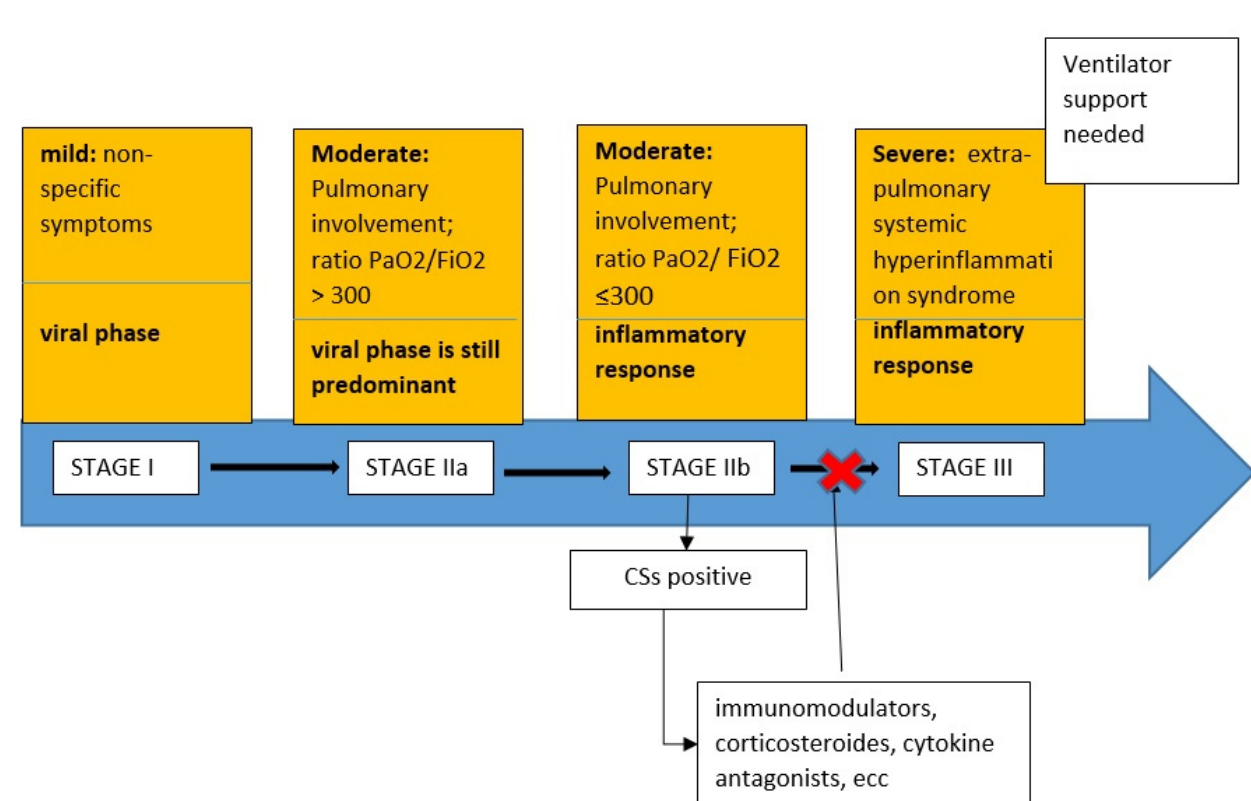
Figure 1. Cytokine Storm Score (CSs) score identifies coronavirus disease 2019 (COVID-19) patients who are doing a cytokine storm, and identifies the timing of correct administration of immunomodulators, corticosteroids, and cytokine receptor antagonists to prevent the progression of stage III COVID-19.